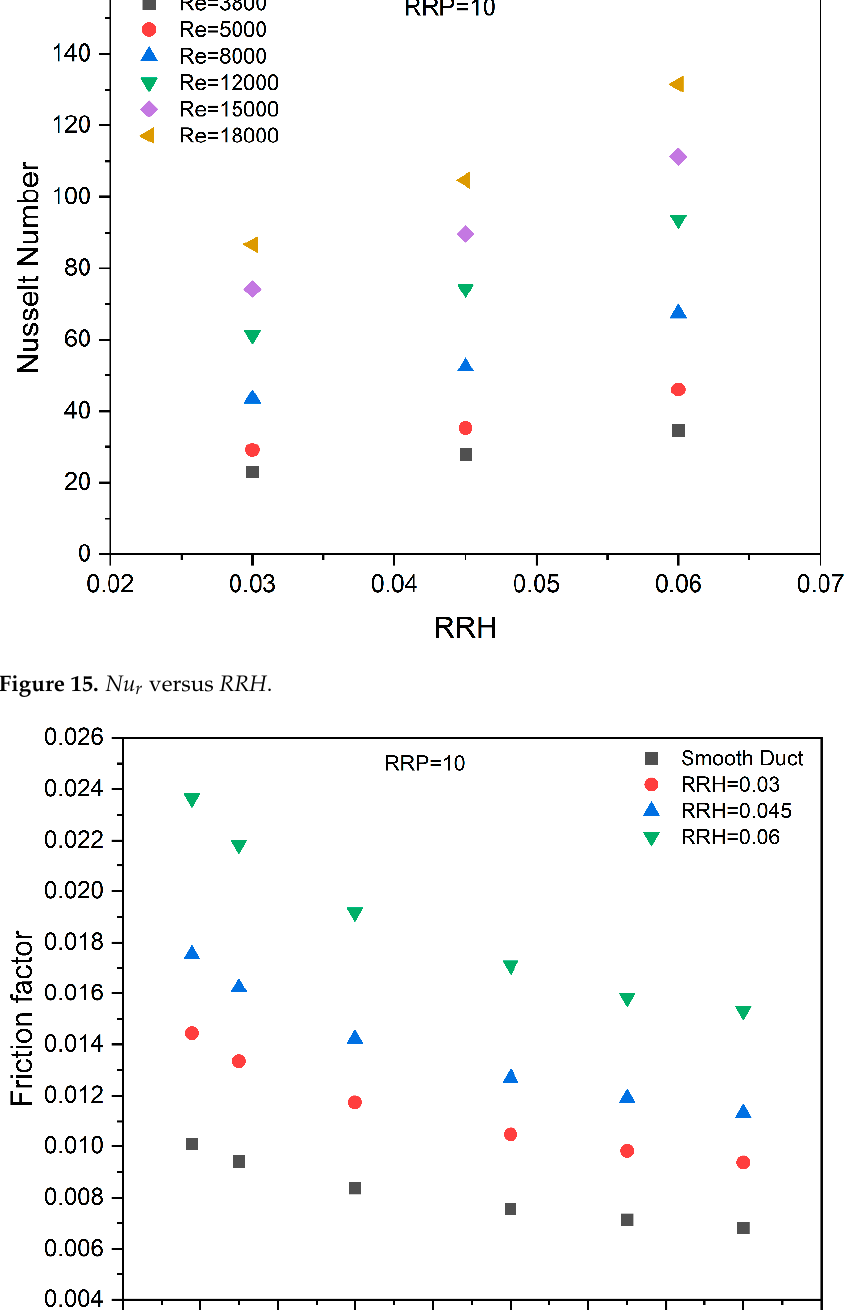
Figure 16. f r versus Re .